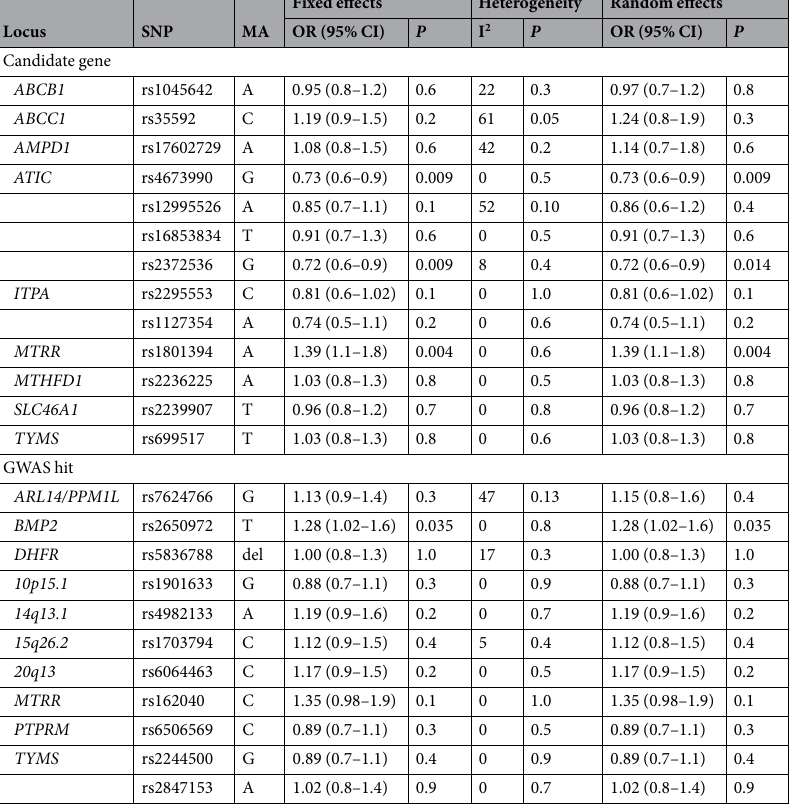
Table 3. Metaanalysis of the association of the 24 SNPs with response to MTX according to the EULAR criteria at 6 months in the four populations of RA patients. Summary odds ratios (OR) and their confidence intervals (95% CI) obtained with fixed effects and random effects metaanalysis are presented together with the inconsistency (I 2 ) and p value of the Cochran Q test for heterogeneity. Multivariate logistic regression in each population included sex, age, baseline DAS28, previous use of DMARD and concomitant treatment with